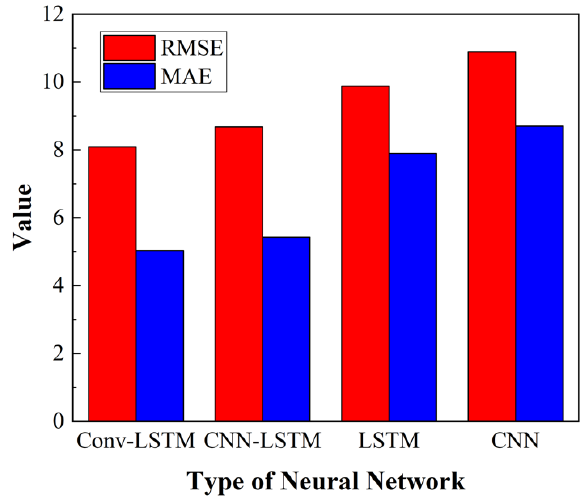
Figure 7. Comparison of Conv-LSTM, CNN-LSTM, LSTM, and